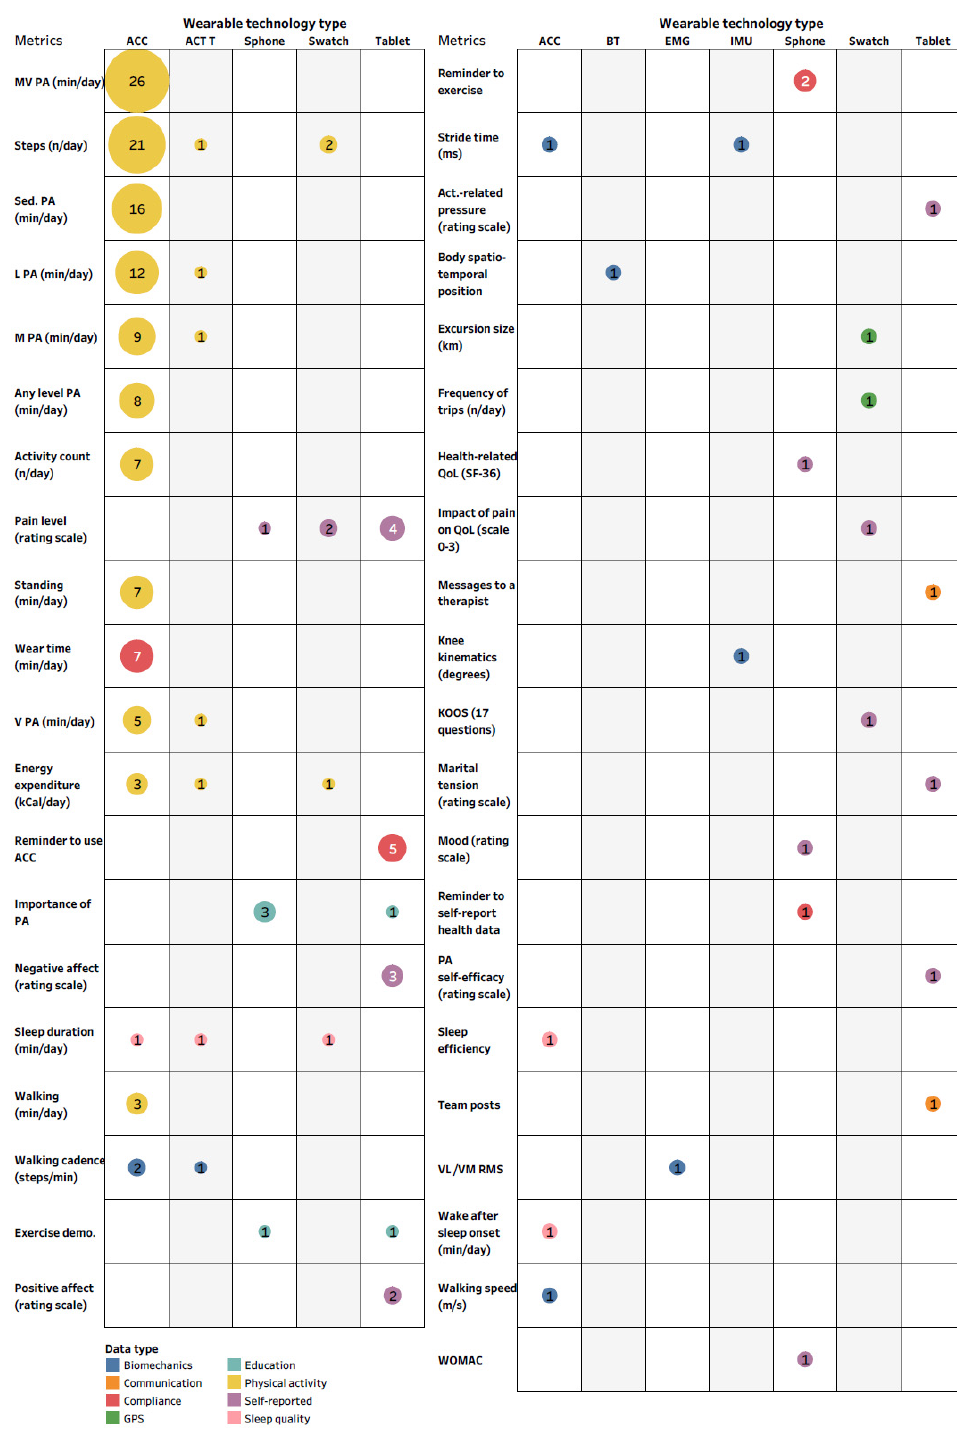
Figure 4. The number of studies by the specific data metrics recorded/transferred from/to the wearer stratified by data type and organized according to the type of wearable technology. Abbreviations: ACC, accelerometer; ACT T, activity tracker; Sphone, smartphone; Swatch, smartwatch; BT, Bluetooth sensors; EMG, electromyography; IMU, inertial measurement unit; PA, physical activity; MV, moderate to vigorous; L, light; Sed., sedentary; demo., demonstration; QoL, quality of life; KOOS, knee osteoarthritis outcome score; VL, vastus lateralis; VM, vastus medialis; RMS, root mean square; WOMAC - The Western Ontario and McMaster Universities Arthritis Index; Interactive version of the figure with all reported metrics and with all the study references is located here: https://public.tableau.com/app/profile/tomasz.cudejko/viz/Figure4_Full/Figure4_Full (accessed on 19 October